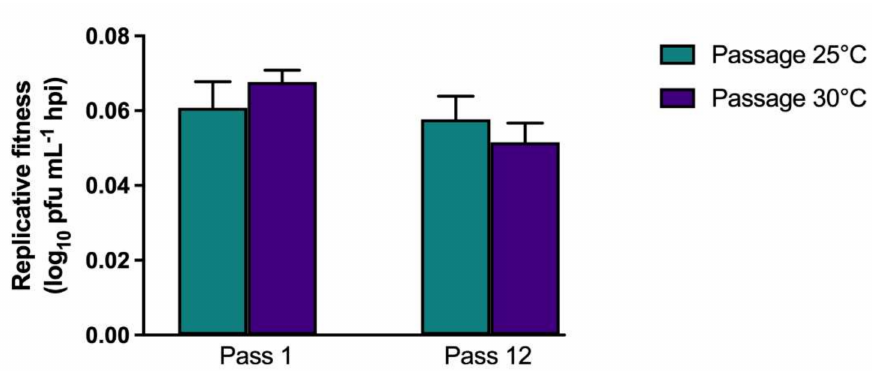
Figure 4. West Nile virus adaptation resulting from passage on mosquito cell culture is host specific. Replicative fitness in avian (PDE) cells of WNV02 IC after passaging in Culex tarsalis (C × T) cells. Replicative fitness is shown as means of replicate assay and lineage. No significant differences were measured when comparing passage number or temperatures ( p > 0.05, one-way ANOVA w/multiple comparisons, Tukey’s